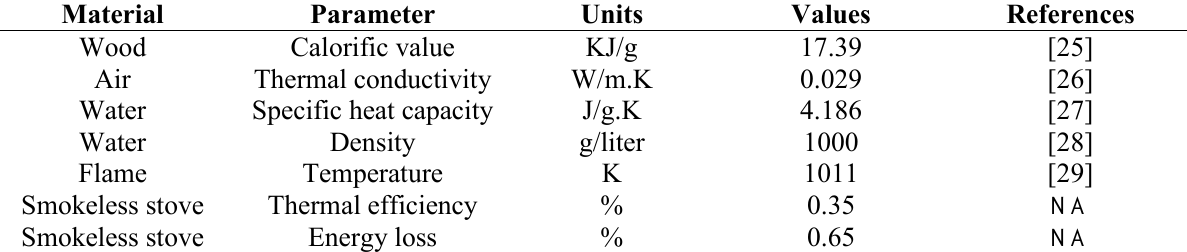
Table 2. Design parameters for the ICS